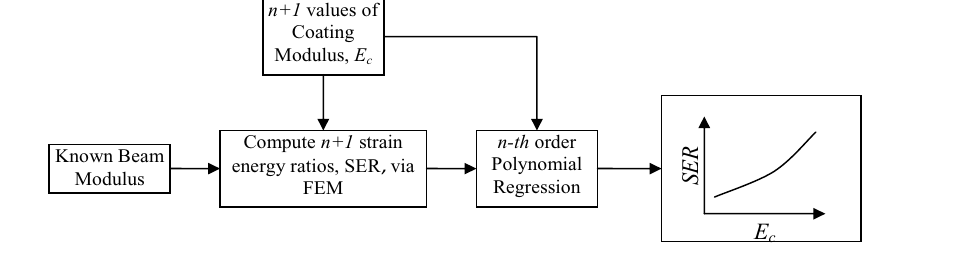
Fig. 12. Polynomial relating strain energy to coating